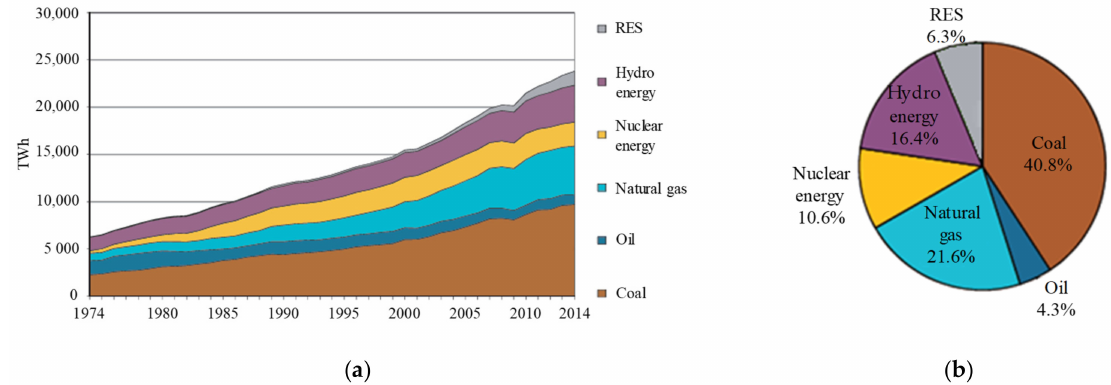
Figure 1. A split of world power production between primary energy sources: ( a ) Changes from 1974 to 2014; ( b ) Power source structure for the 2014 year.